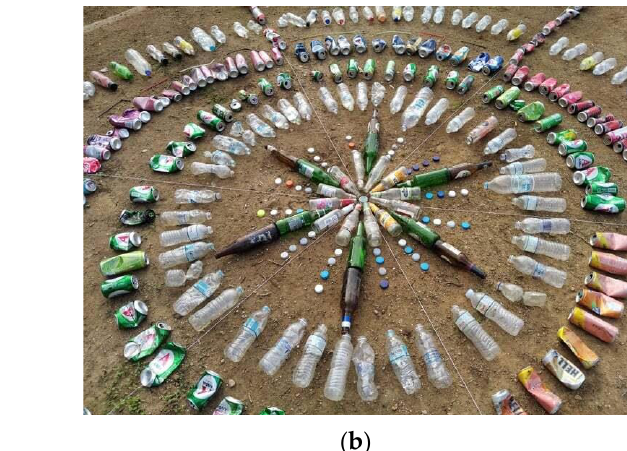
Figure 4. Communication artist Christine Katsari creating a mandala with trash collected on the site ( a ) and the mandala completed ( b ) (Photo credit: Lena Kita).